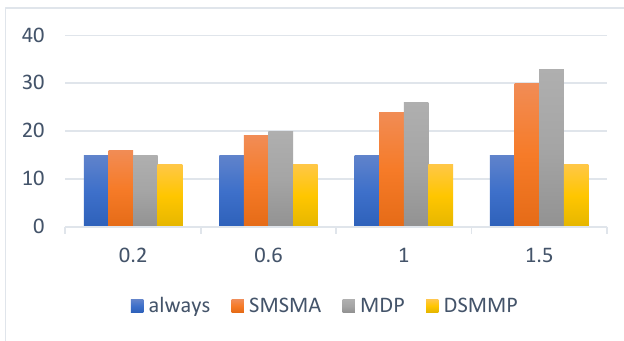
Figure 7. Effect of overhead factor on communication distance.